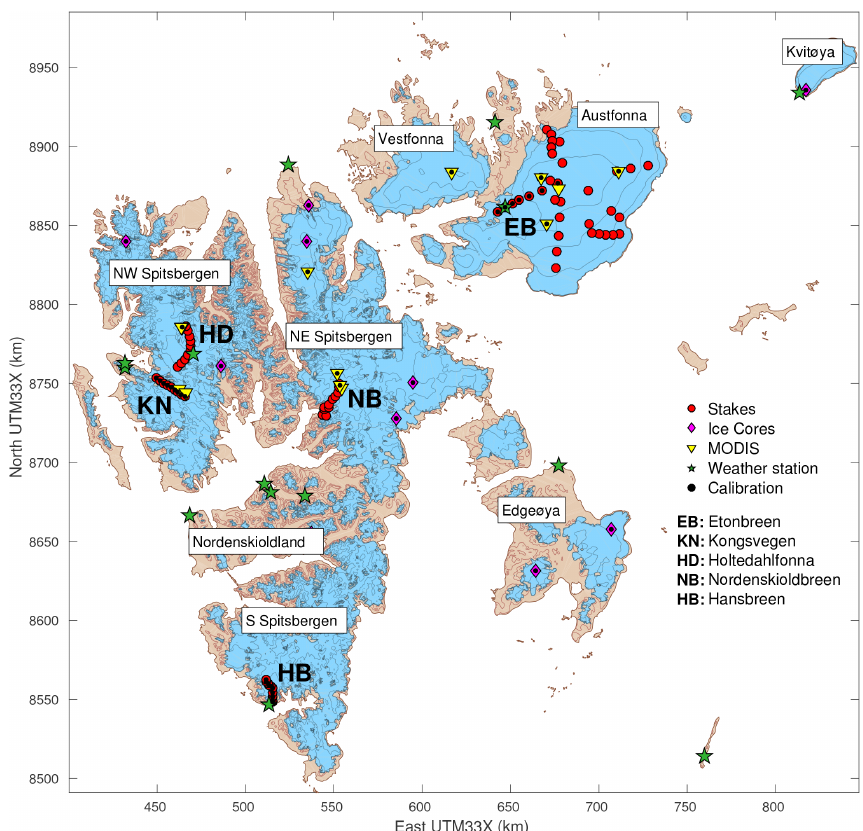
Figure 1. Map of Svalbard with names of regions and the five glaciers described in the text; glacierized area is shown in blue. Markers show the locations of observations and the black dots mark the calibration sites. Lines mark elevation above sea level in 200m